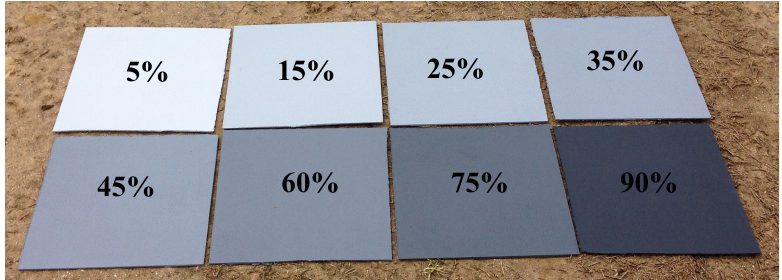
Figure 2. Grey calibration panel built to associate surface reflectance values with image raw digital numbers. The panel consisted of eight reference surfaces painted with a grey gradient ranging from 5% to